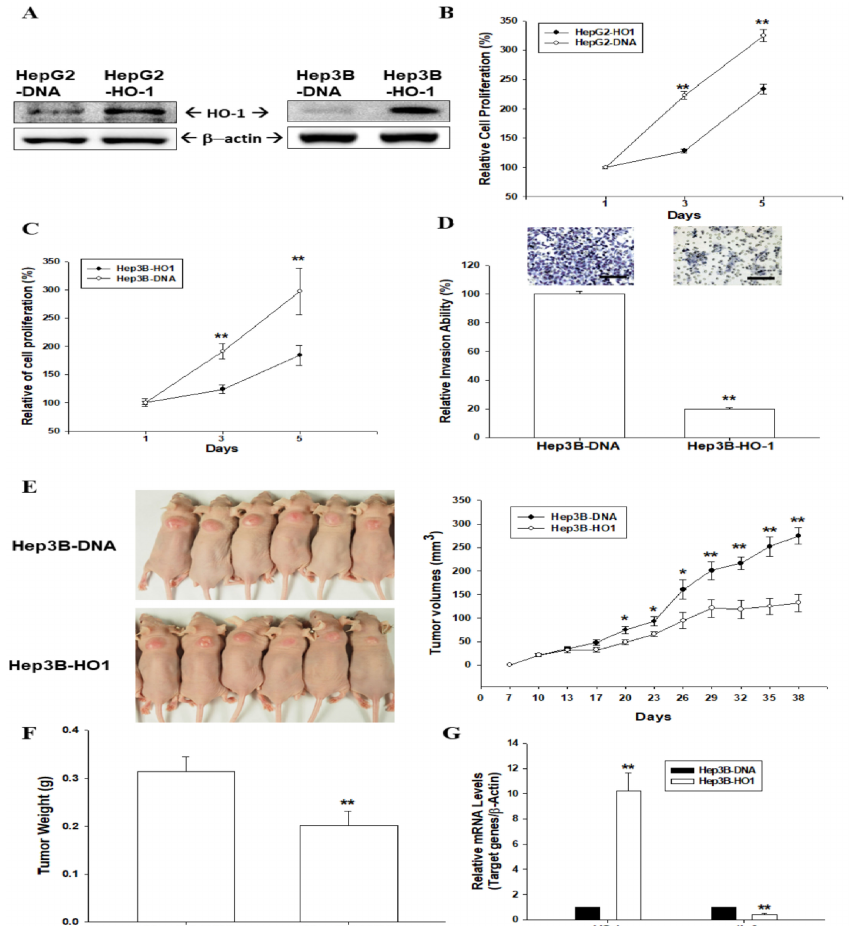
Figure 1. HO-1 attenuates cell proliferation and invasion of human hepatoma cells. ( A ) HepG2 (left) and HepG3 (right) cells were transiently overexpressed the HO-1 expression vector. The protein levels of HO-1 were determined by immunoblot assays. The cell proliferation rates in HepG2–DNA and HepG2-HO1 ( B ), and also in Hep3B–DNA and Hep3B-HO1 ( C ) cells, were determined by 3 H-thymidine incorporation assays ( D ) The invasive abilities of Hep3B–DNA and HepG3B-HO-1 cells were determined by in vitro Matrigel invasion assays. Data are presented as the mean percentage ( ± SE, n = 3) of invasion ability in relation to that of the Hep3B − DNA cell group. The scale bar is 50 µ m. Four-week-old male athymic nude (nu / nu) mice were randomized into two groups: Hep3B–DNA ( n = 6) and Hep3B-HO1 ( n = 6). Hep3B–DNA and Hep3B-HO1 cells (8 × 10 6 ) were injected into the dorsal subcutaneous area, respectively. Tumor growth rates ( E ) were measured every 3 days, starting at the first week of growth (day seven) in which the tumors became perceptible under the skin after inoculation. The tumor weight ( F ) and mRNA levels of HO-1 and IL-6 ( G ) were determined by RT-qPCR after animals were sacrificed. (*, p < 0.05; **, p <